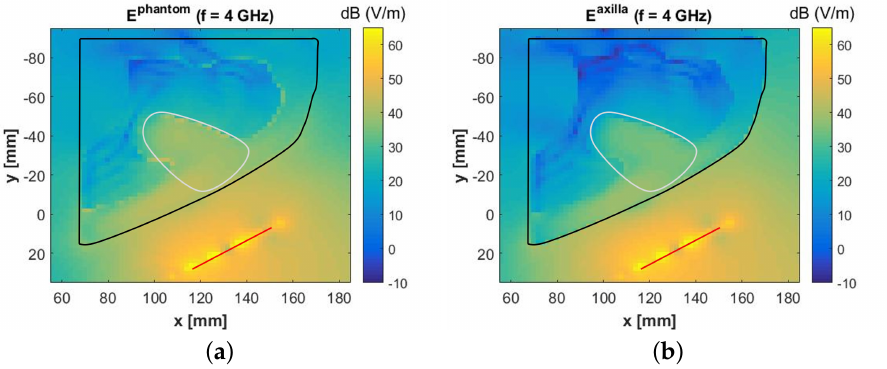
Figure 11. Magnitude of the electric fields ( f = 4 GHz) computed, at the level of the sternum, when considering two different setups. ( a ) E phantom , referring to the setup in Figure 9b. ( b ) E axilla , referring to the setup in Figure 9c. The electromagnetic source is the crossed Exponentially Tapered Slot (XETS) antenna illustrated in Figure 10a. The black line identifies the contour of the axillary region (i.e., polymeric external shell in case ( a ) and skin in case ( b )). The white line identifies the axillary lymph node region. The red line identifies the antenna.